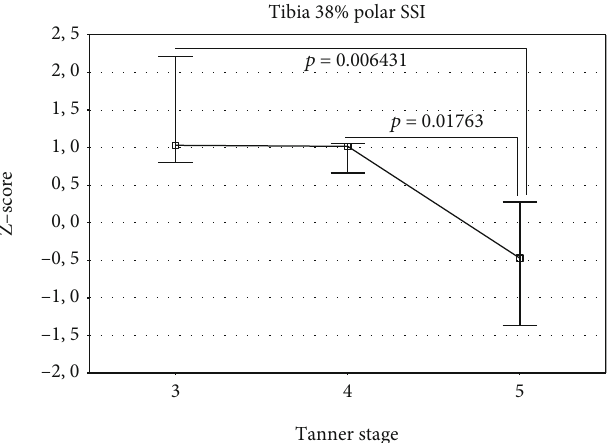
Figure 5: Z -scores for tibia 38% polar SSI in boys by Tanner stage (median and Q1-Q3). Table 6: Z -scores for bone turnover markers in comparison with hypothetical mean zero by sex. Female: mean (SD) Male: mean (SD) p value (di ff . between female and male) p value (di ff . from 0) p value (di ff . from 0) -0.17 (0.91) Osteocalcin (micro g/ml) -0.64 (0.67) ( p = 0 : 0003994 ) ( n = 20 ) 0.0865 0.4799 ( n = 15 ) 0.66 (1.36) C-terminal telopeptide (ng/ml) -0.68 (0.59) ( p = 0 : 00009919 ) ( n = 19 ) 0.003083 0.0903 ( n = 14 )